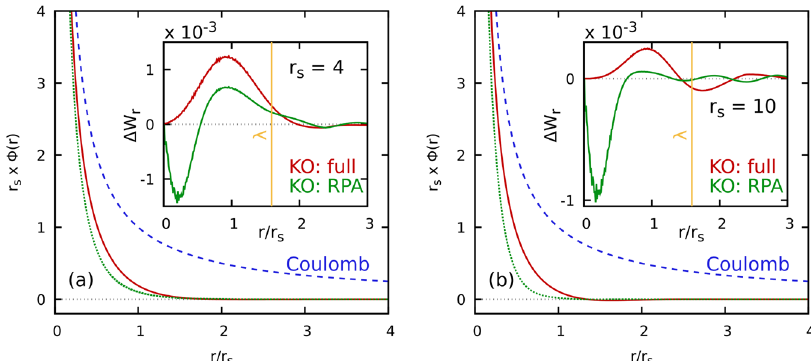
Fig. 3 Effective Kukkonen Overhauser (KO) potential between a pair of electrons surrounded by the electronic medium. Dotted green: random phase approximation (RPA); solid red: full KO potential using exact PIMC data for the local fi eld correction (LFC) G ( q , 0) 40 ; dashed blue: bare Coulomb. The inset shows the contribution Δ W r ( q ) to the full shift Δ W ( q ) for q ≈ 2 q F within LFC and RPA as a function of the distance between the particles r . a For r s = 4, positive and negative contributions to Δ W ( q ) approximately cancel within the RPA, and the red-shift in ω ( q ) is mainly due to the reduction of the interaction energy described by the exact path integral Monte Carlo (PIMC) results. b For r s = 10, the RPA even predicts an unphysical increase of W , whereas our PIMC results again correctly describe the minimization of the interaction energy for λ ~ d